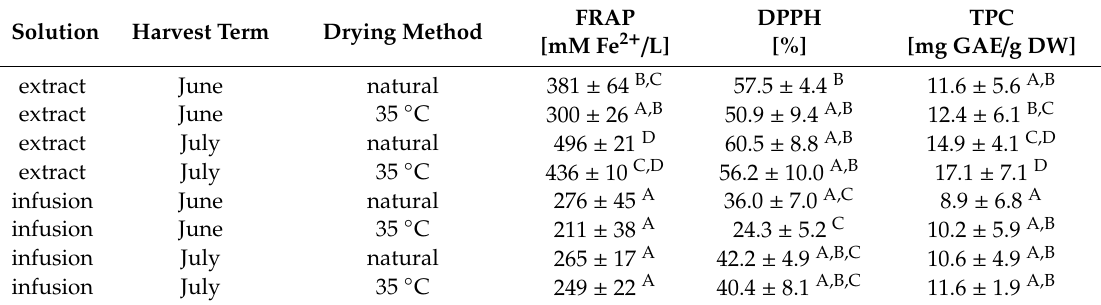
Table 4. E ff ect of harvest period and drying method on antioxidant activity indicators (FRAP, DPPH and TPC) marked in salvia